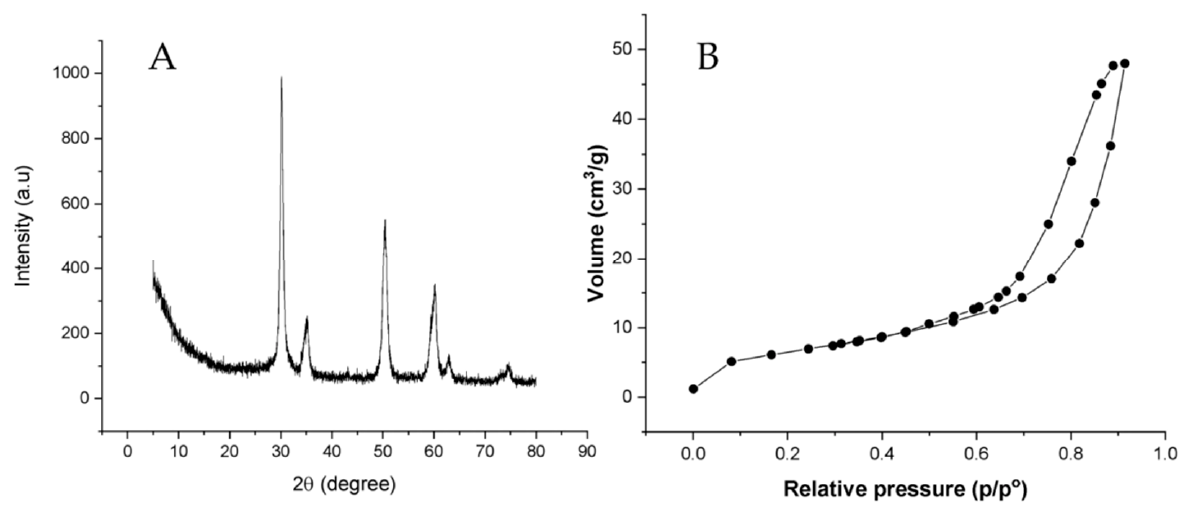
Figure 2. PXRD pattern ( A ) and N 2 adsorption–desorption isotherms ( B ) of nano-ZrO 2 .